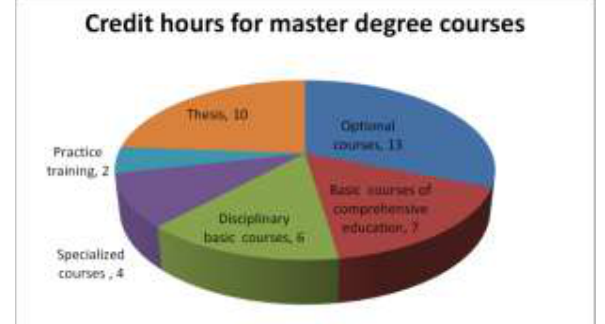
Figure 3. Credit hours distribution for the master degree